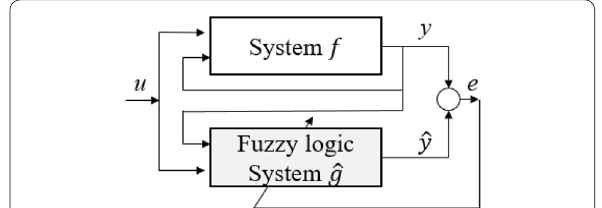
Fig. 4 Parallel model using fuzzy logic